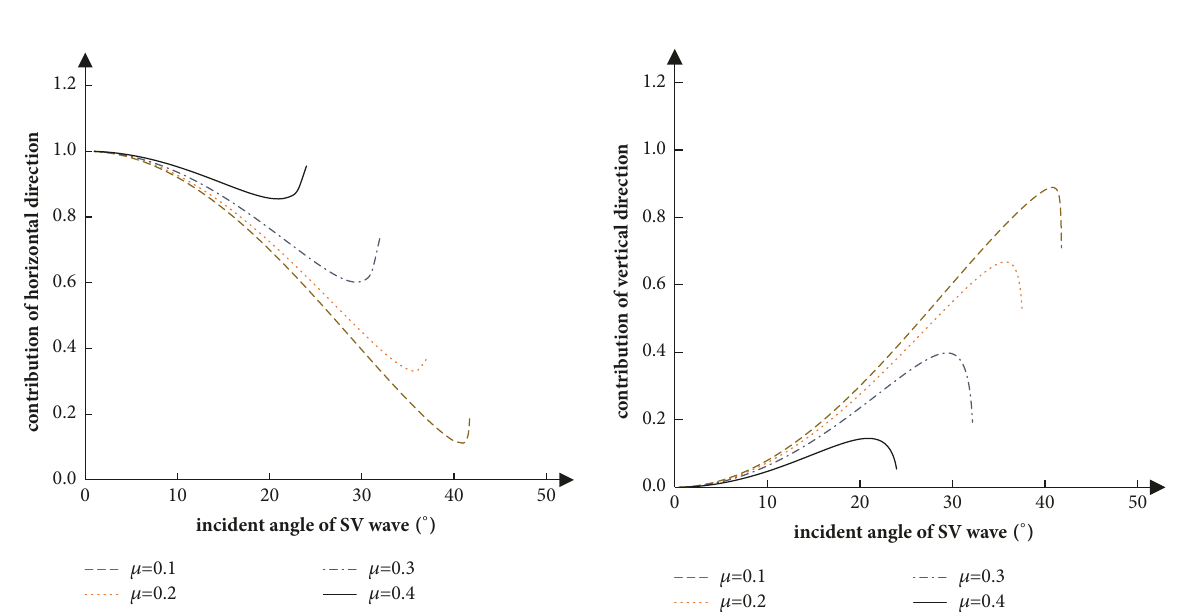
Figure 4: Contribution of SV wave to the design ground motion on the free surface.